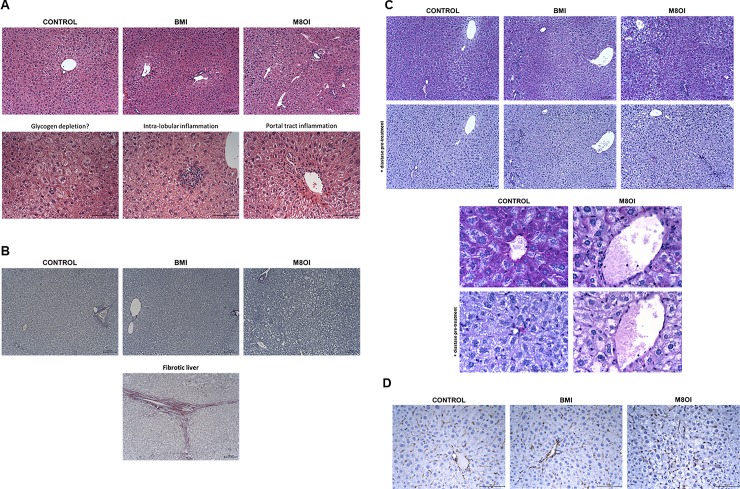
Histopathological effects of BMI or M8OI exposure in the liver.A, upper panels, typical low powered views of liver sections stained with H&E from the indicated treatment groups. Lower panels, high powered views of some changes:- hypoeosinophilia (left panel) which was more widespread in M8OI-treated mice but also present in other groups and intra-lobular and portal tract inflammation, both observed to a near similar extent in all groups. B, typical low powered views of liver sections stained with Sirius red (staining collagen fibres red), followed by haematoxylin from the indicated treatment groups. Lower panel, positive control–liver section from a donor liver organ with cirrhosis. C, typical low powered views (upper panels) and high powered views (lower panels) of liver sections stained with PAS from the indicated treatment groups, with where indicated, diastase treatment. D, typical low powered views of liver sections immunostained for vimentin from the indicated treatment groups. Size bar = 100μm throughout.